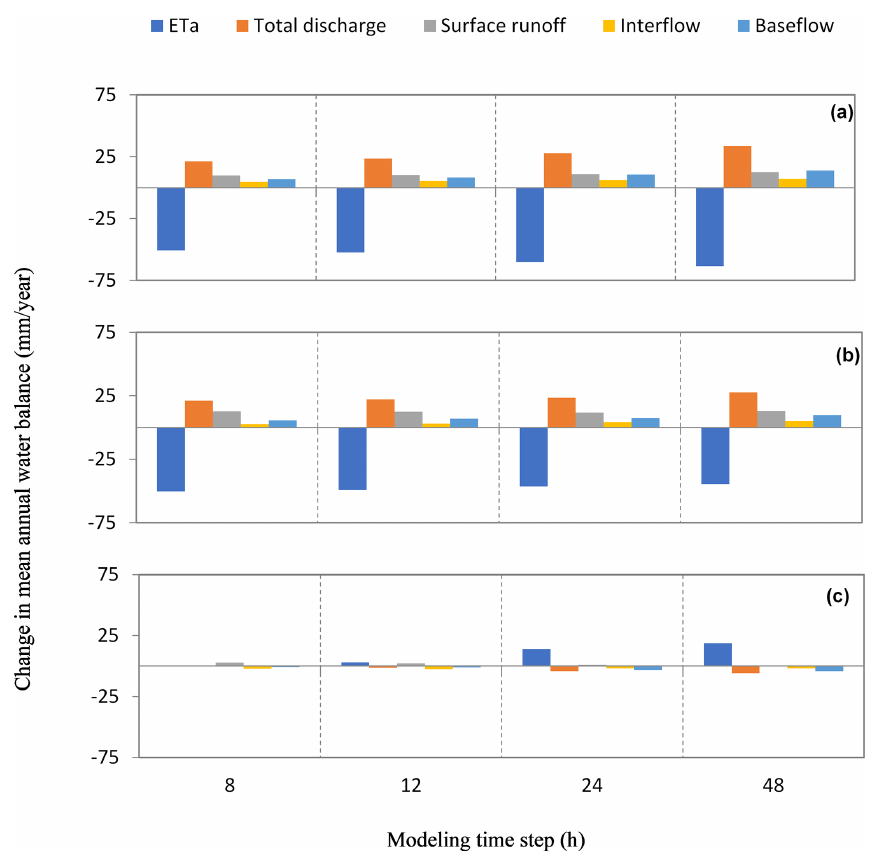
Figure 5. Change in water balance as a result of LULC change, modeling time step and soil parameterization. Part (a) compares LULC1990 to LULC2013 using a classic soil-CS, part (b) compares LULC1990 to LULC2013 using a refined soil-RS, and (c) shows the difference between soil parametrization approaches (a, b) .